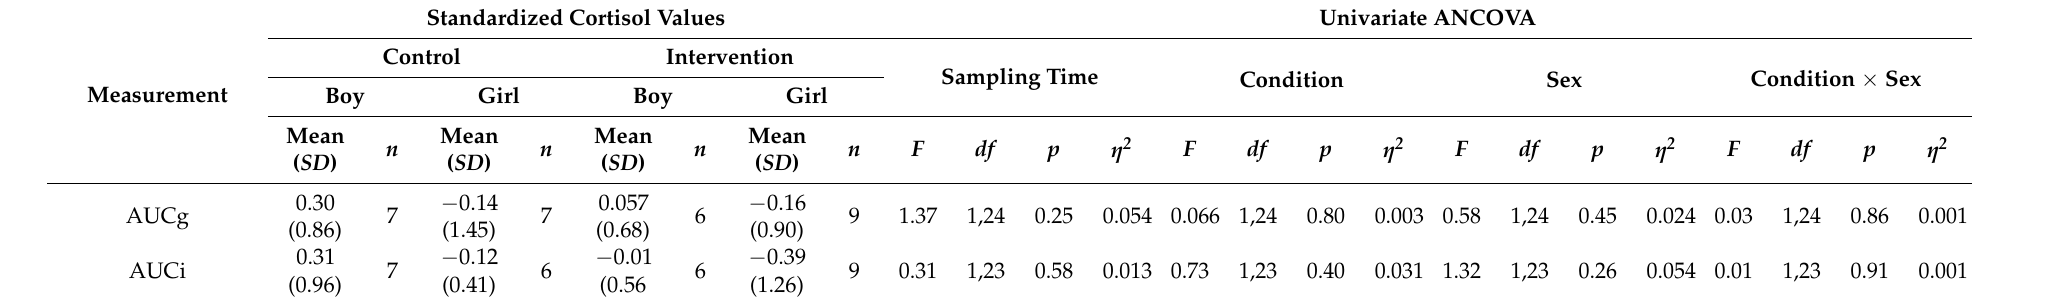
Table A6. Effects of the intervention, sex and sampling time on stress-induced cortisol responses.